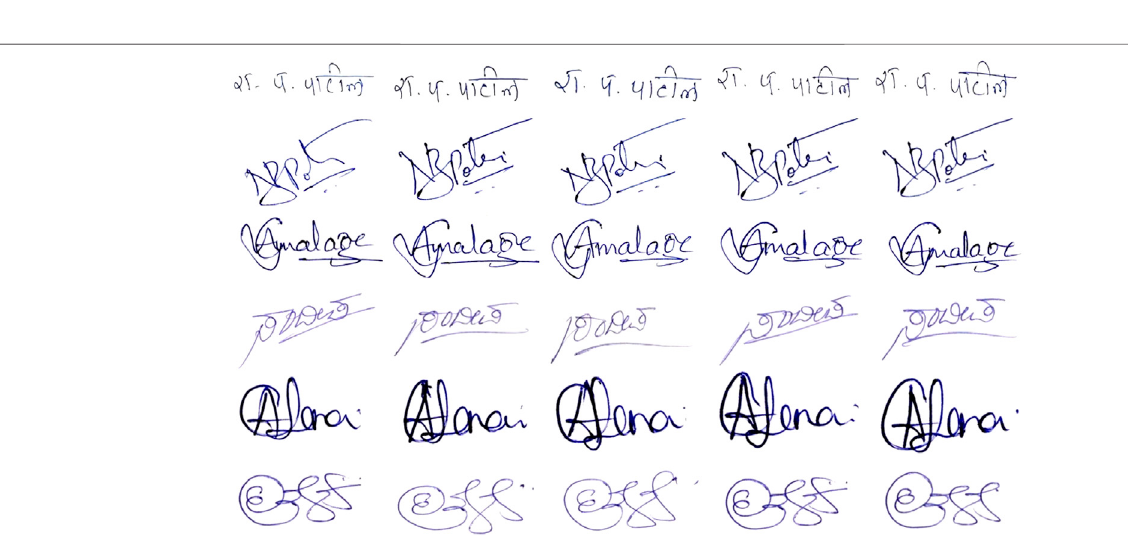
FIGURE 2 | Handwritten signature samples from the own